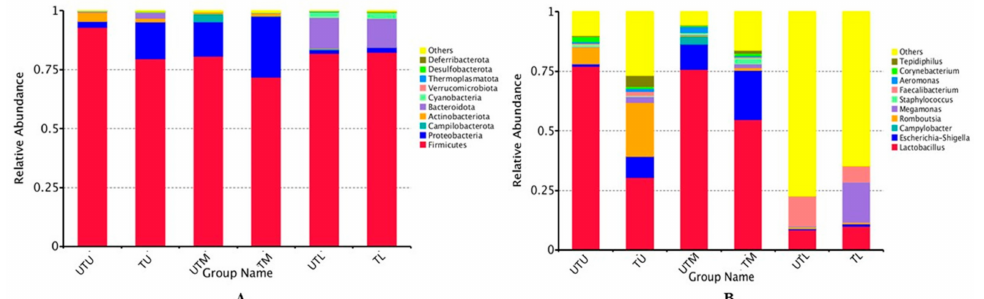
Figure 1. Box charts depicting the top 10 phyla ( A ) and genera ( B ) in both treated (T) and untreated (UT) groups in each section of the GIT (upper (U), middle (M), lower